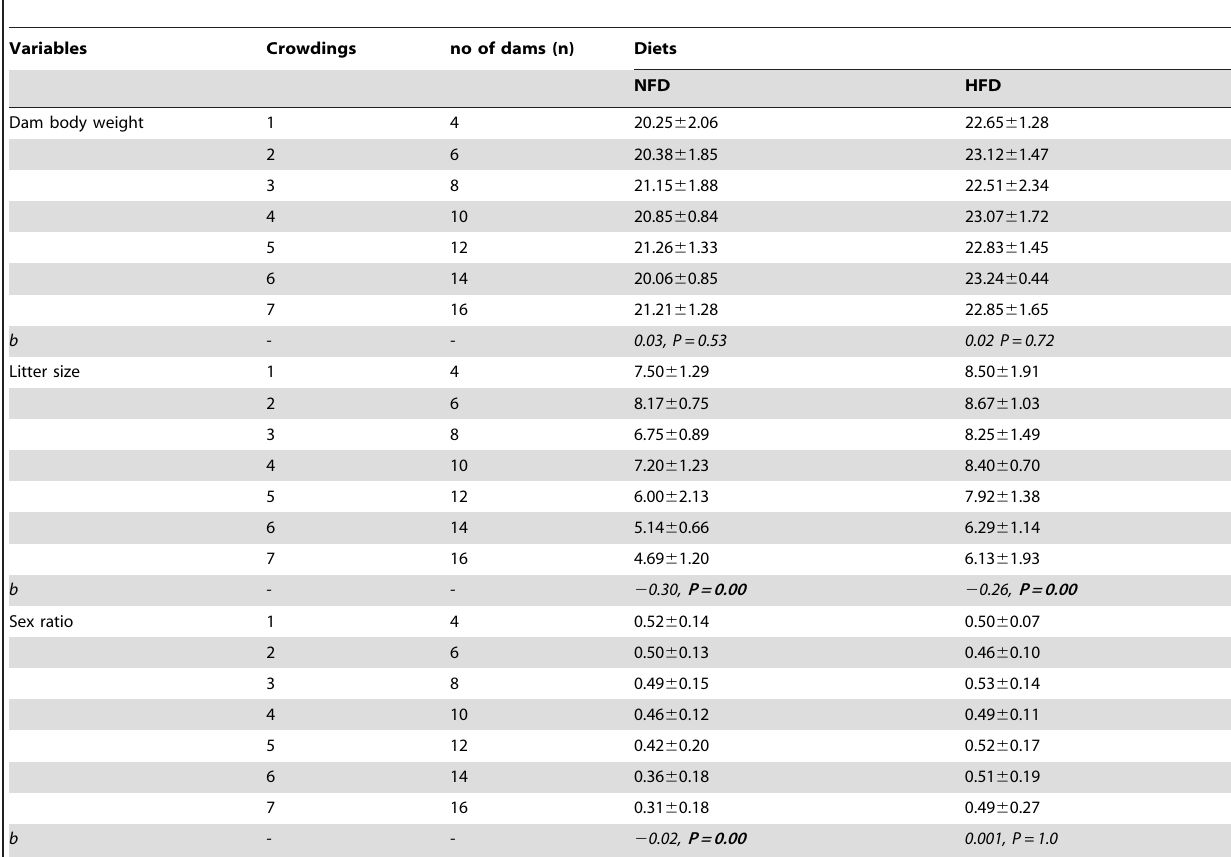
Table 1. The summary (Mean 6 SD) of dam body weight, litter size and sex ratio from NFD and HFD groups.